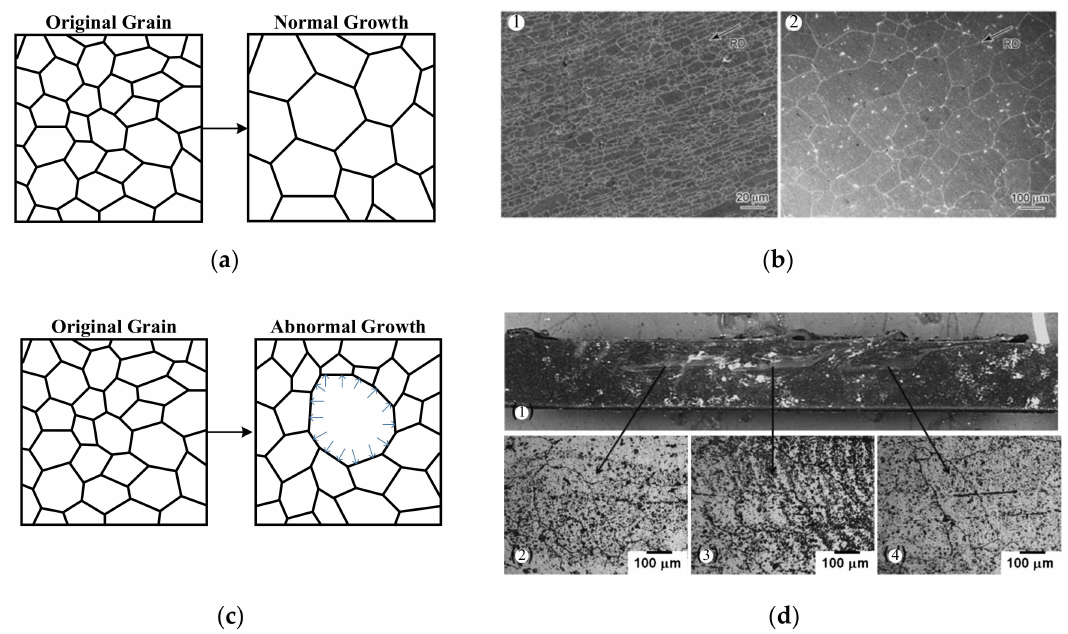
Figure 5. Grain growth of aluminium alloys. ( a ) Schematic and ( b ) corresponding experimental observation for normal grain growth. The experimental observation is of as-extruded AA7055 before (left) and after (right) annealing at 520 ◦ C for 90 min (Reproduced with permission from Springer Nature [70]); ( c ) Schematic and ( d ) corresponding experimental observation for abnormal grain growth. The experimental observation is of friction stir processed Al-7Si-0.6 Mg alloy (Reproduced with permission from Elsevier [71]).